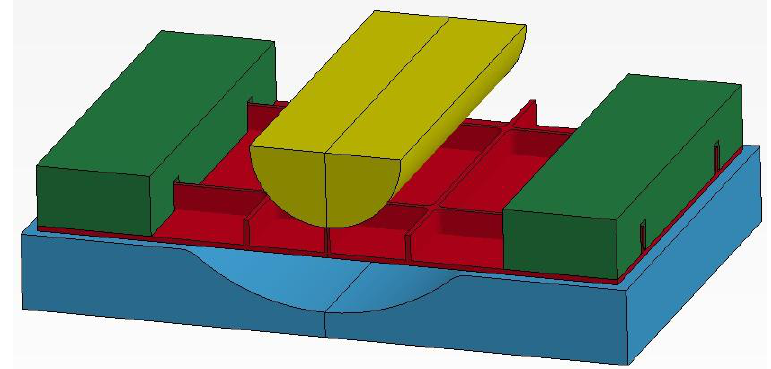
Figure 21. Geometric model of the brake forming (BF) process.